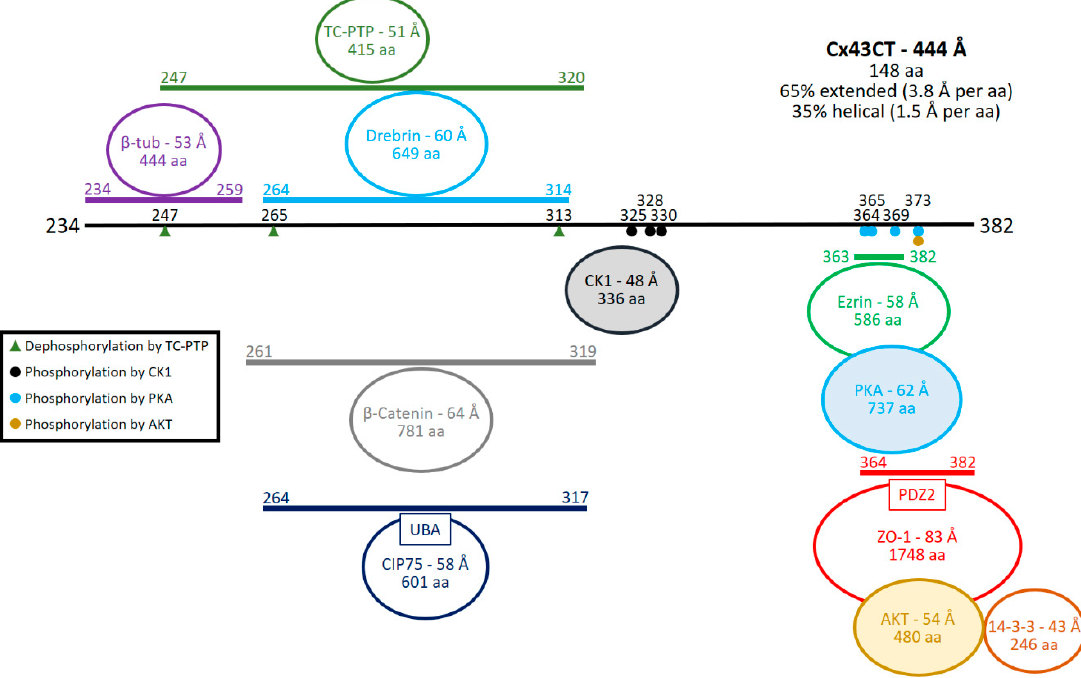
Figure 1. Protein partners that directly interact with the Cx43CT domain to promote intercellular communication. The black line represents Cx43CT domain residues 234–382. Provided for each Cx43CT protein partner (circle) is its diameter (in Å) as estimated from their molecular weight, and number of amino acids (aa), and the Cx43CT residues affected as a result of the interaction (lines). If the protein partner is a kinase or phosphatase, the Cx43CT residues affected are labeled on the Cx43CT (circle or triangle). Abbreviations are as follows: β -tubulin ( β -tub), T-cell protein tyrosine phosphatase (TC-PTP), Connexin interacting protein 75 kDa (CIP75), Ubiquitin-associating domain (UBA), Casein kinase 1 (CK1), Protein kinase A (PKA), Zonula Occludens 1 (ZO-1), and Protein kinase B (AKT). Kinases have been highlighted (shaded circle).